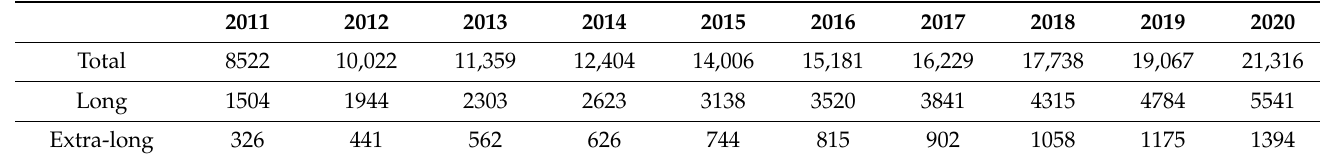
Table 1. Progress of tunnel construction in China (2011–2020).